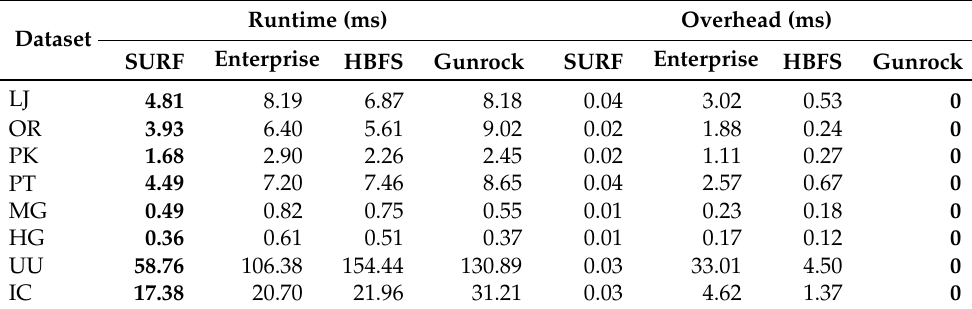
Table 4. Computational overhead and runtime. The best case among the four methods is shown in bold.